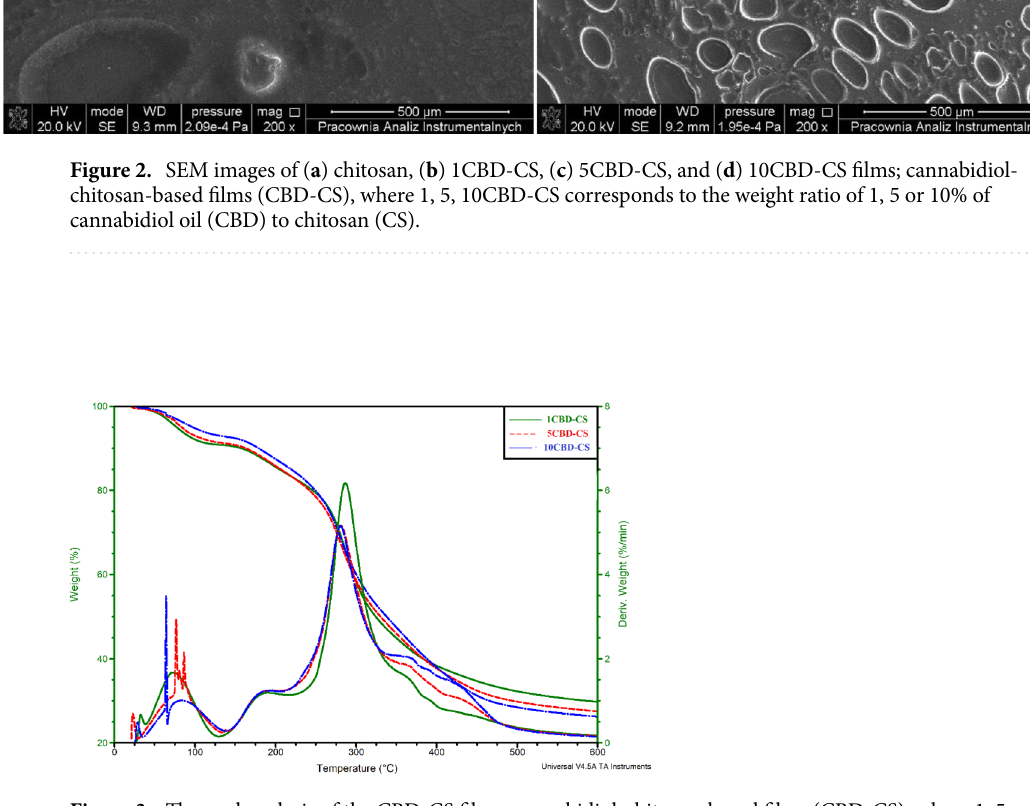
Figure 3. Thermal analysis of the CBD-CS films; cannabidiol-chitosan-based films (CBD-CS), where 1, 5, 10CBD-CS corresponds to the weight ratio of 1, 5 or 10% of cannabidiol oil (CBD) to chitosan